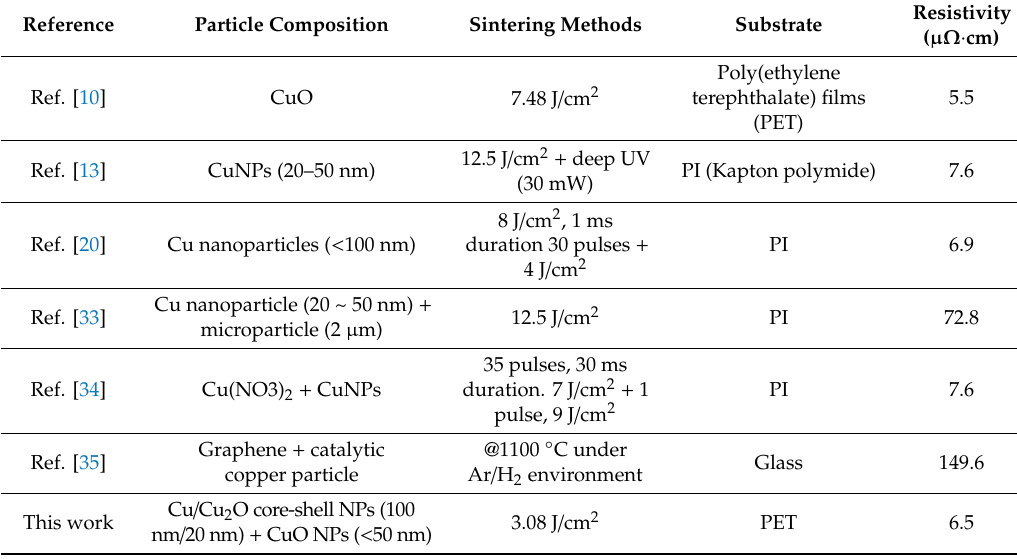
Figure 7. Cross section SEM images of ( a ) sintered Cu film and ( b ) sintered Cu/CuO film, and ( c ) XRD patterns comparison. Table 1. Comparison of copper thin film from IPL sintering.